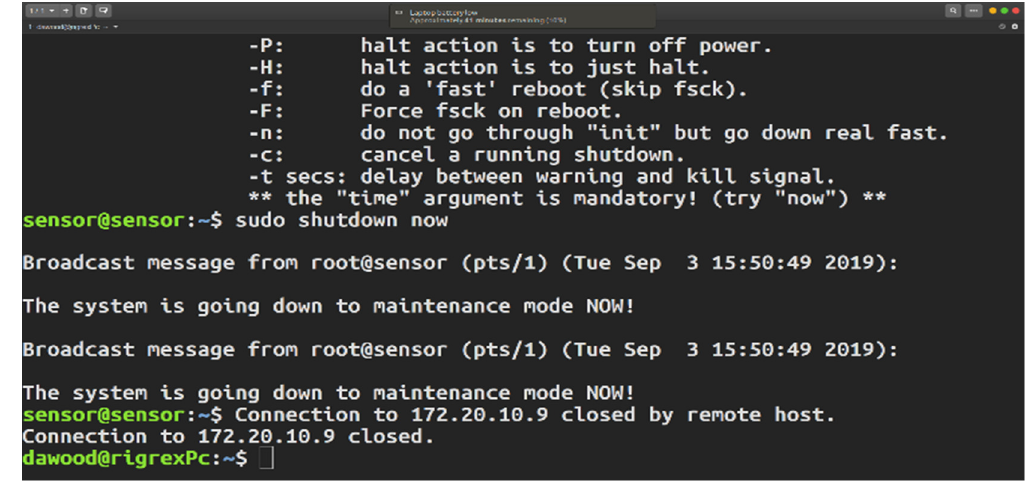
Fig. 8: IEMS control shutting down due to DoS